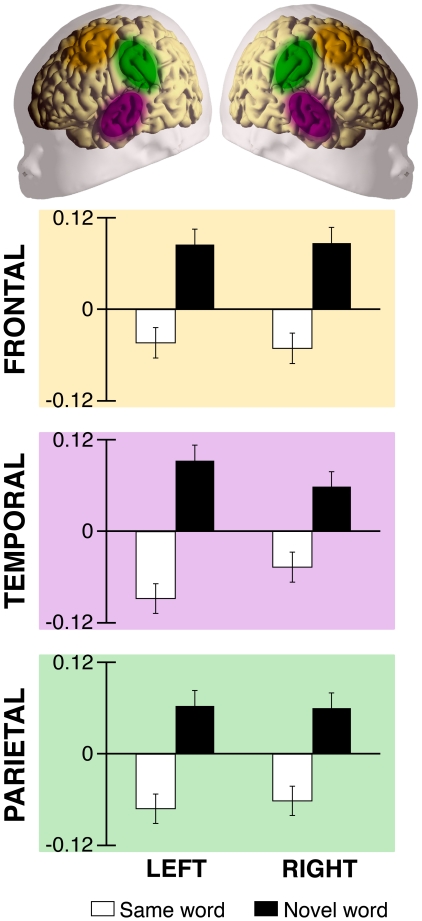
OxyHb changes from the last familiarization block to the first test block (Study 1).Channels bilaterally located in frontal, temporal and parietal areas show a decrease in the concentration of oxyHb when neonates hear the same word before and after the pause (white bar). In contrast, when neonates are confronted with a novel word in the test (black bar) the concentration from the familiarization phase to the test increases. Colored ellipses on the schematic neonate brain indicate the localization of the channels included in the areas of interest.